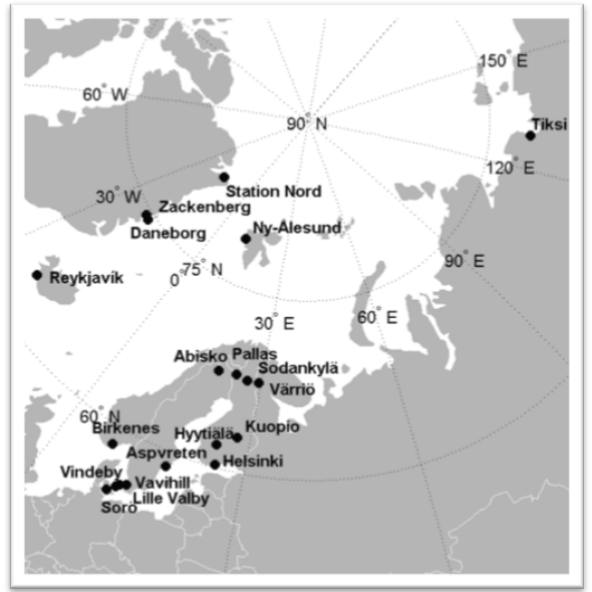
Figure 3. Map of the core field stations in CRAICC: Troll station, Antarctica; Vavihill, Sweden; Birkenes, Norway; Lille Valby, Denmark; Vindeby, Denmark; Sorø, Denmark; Aspvreten, central Sweden; SMEAR III, Finland; SMEAR II, central Fin- land; SMEAR IV, Kuopio, central Finland; Sodankylä, Finland; SMEAR I, Värriö, Finland; Abisko, Sweden; Pallas GAW station, Finland; Tiksi, Siberia; Daneborg and Zackenberg, Greenland; Ny- Ålesund, Spitzbergen (Svalbard, Norway); Villum research station,